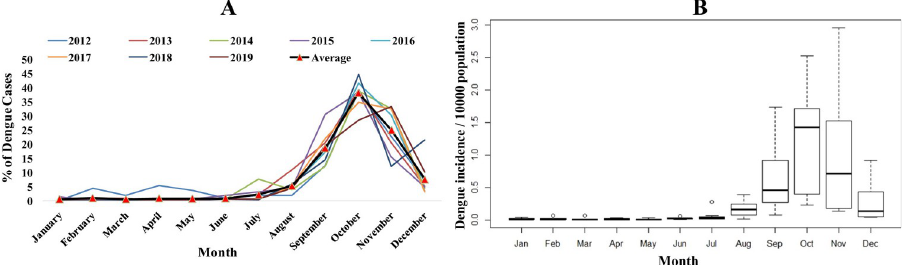
Fig 2. Month wise distribution of dengue cases in Bhopal city (2012–2019). A) Month wise percentage contribution of dengue cases. B) Month wise box plot distribution of dengue case incidence per 10,000 inhabitants (The box comprises 50% of the distribution, the line within the box is the median value, borderlines are the first and the third quartile, and the small circles are the outliers. February, March, June, and July had